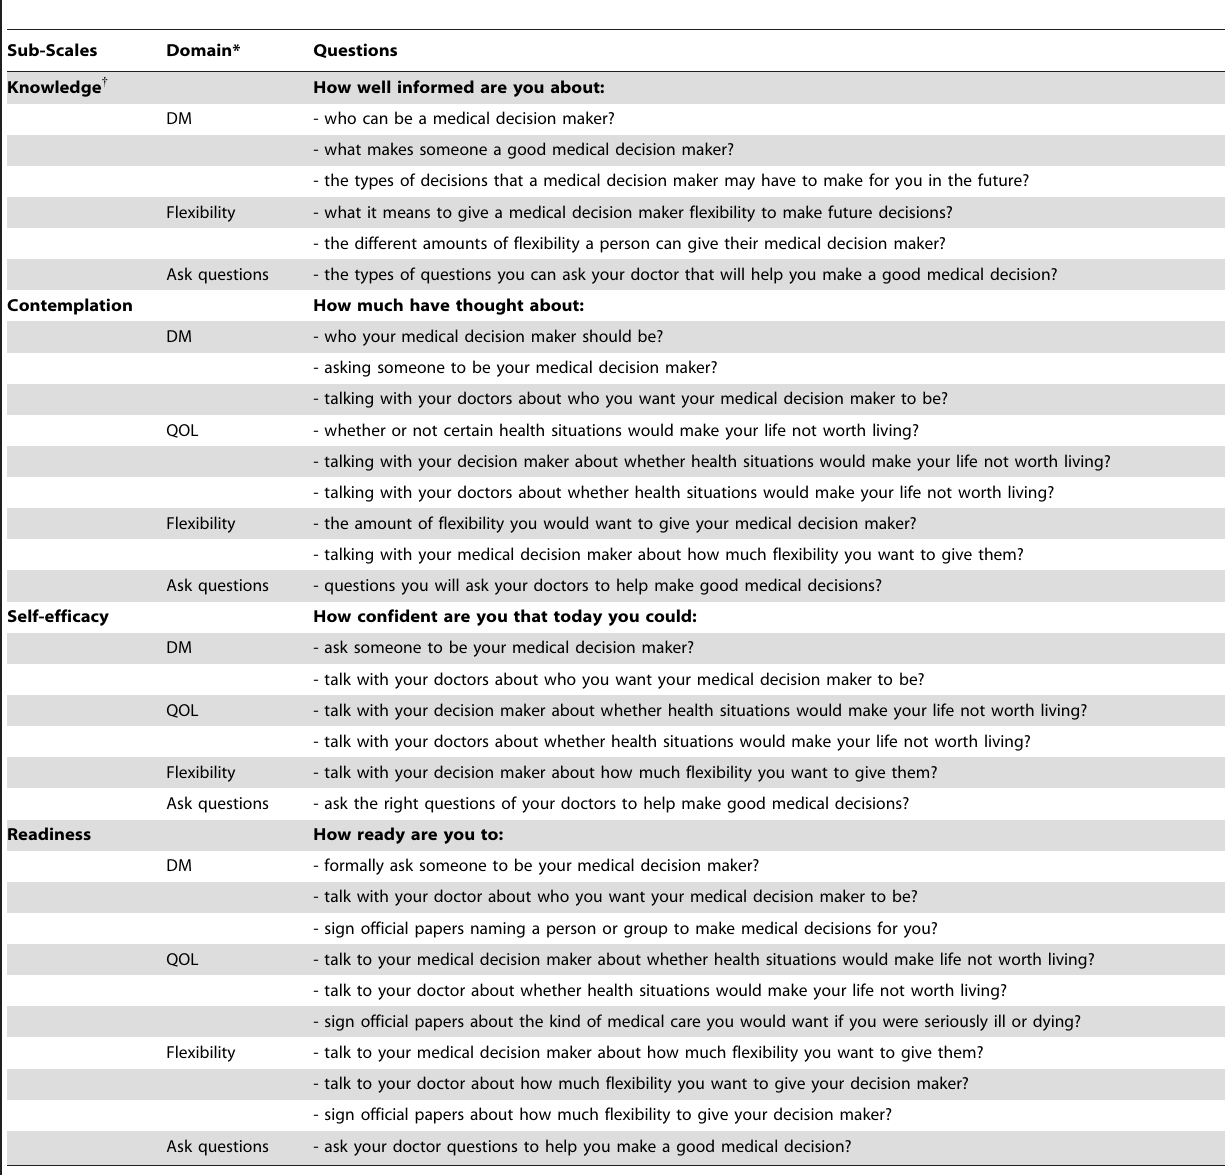
Table 1. Advance Care Planning Engagement Survey – Process Measures: Behavior Change Sub-scales, Advance Care Planning Domains, and